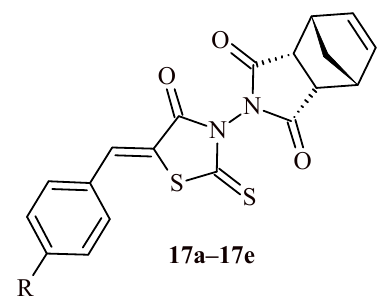
Figure 9. Rhodanine derivatives that inhibited